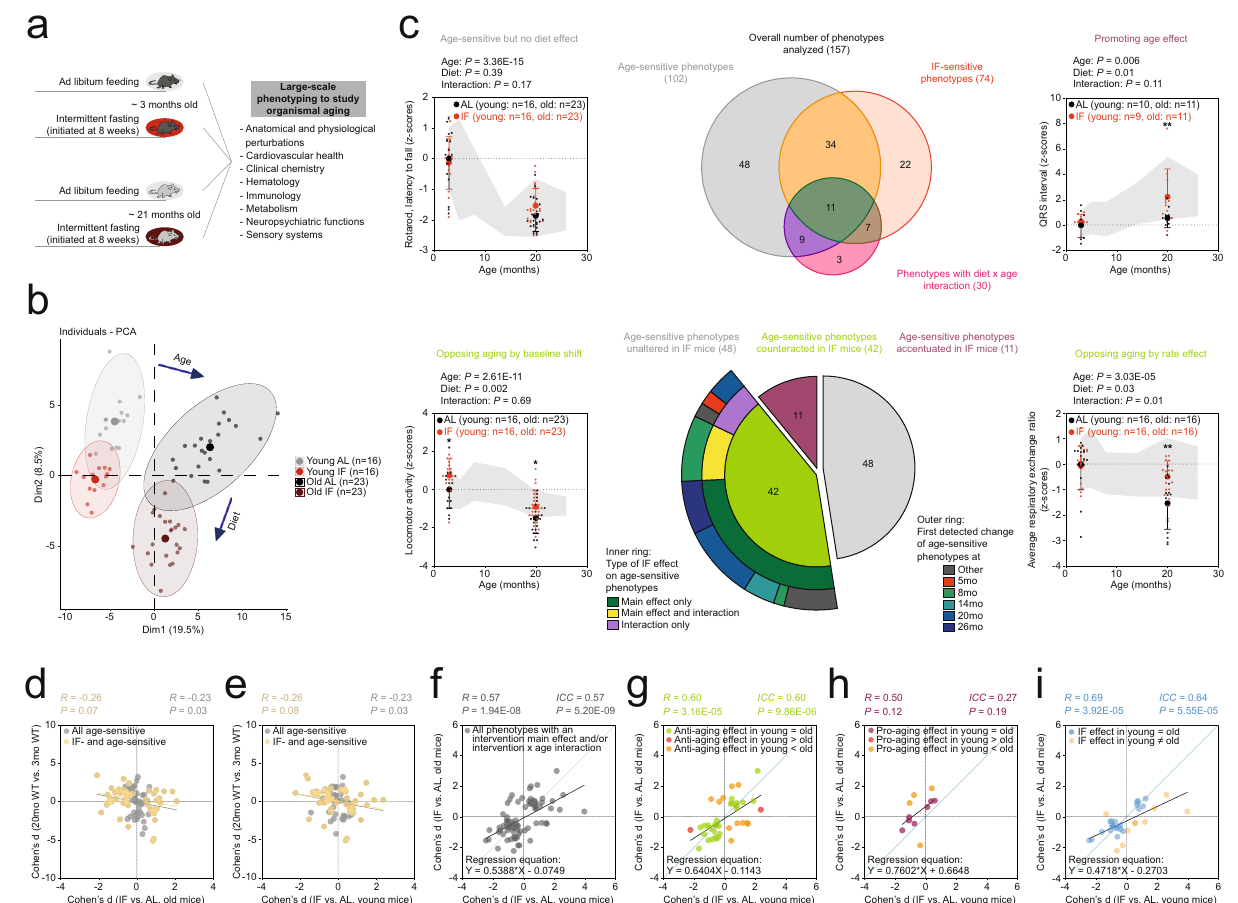
Fig.8| ‘ Anti-aging ’ effectsinducedbyintermittentfasting(IF)oftenmanifestin youngmice(priortodetectableage-dependentphenotypicchanges).a – i Deep phenotyping results in IF mice. a Schematic illustration of study design. Mouse symbolsadaptedfromref.10. b Principalcomponentanalysisofdeepphenotyping data. c Venn diagram shows the number of ASPs, diet-sensitive phenotypes, phe- notypes with a diet×age interaction and their intersection. Sunburst chart shows thenumberofASPseitherunaltered,counteractedoraccentuatedbydiet.ForASPs counteracted by diet, the inner ring shows the proportion of phenotypes with eitheradietmaineffect,adiet×ageinteractionorboth.Theouterringshowswhen changes in the corresponding ASPs were fi rst detected in our baseline study. Line charts show representative examples of phenotypes in fl uenced by age and/or intervention in the different possible ways. Data are presented as z-scores (nor- malized to the young WT group) and are plotted as mean+/ − S.D. (individual data pointsaresuperimposed).Two-wayANOVAswiththebetween-subjectsfactorsage